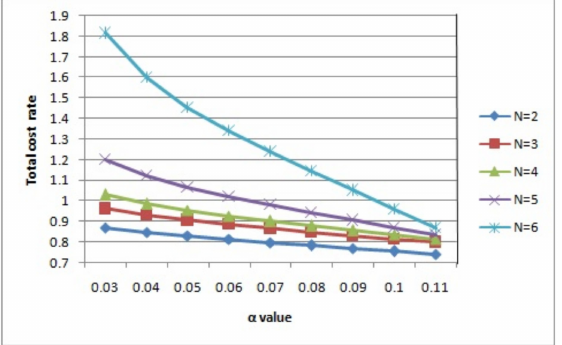
Figure 2. TC (32,11) vs. α , H = 8, β = 0.95, µ = 1.04, γ = 0.6, C C = 0.1, C S = 0.8, C B = 0.07, C P = 0.05, C R = 0.1, C W = 0.1.